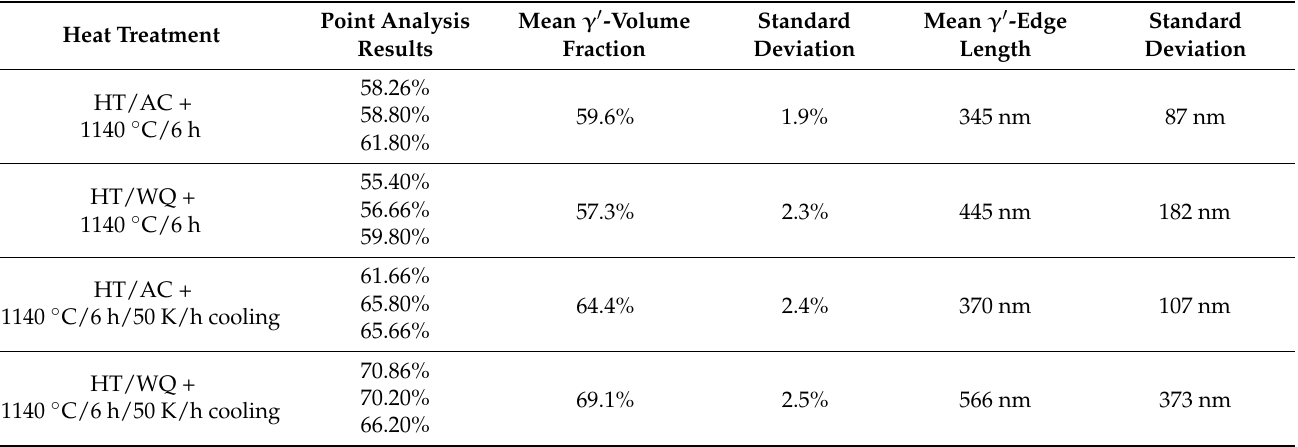
Table 2. γ (cid:48) -edge length and γ (cid:48) -volume fraction of the AC and WQ samples with additional heat treatment at 1140 ◦ C with subsequent AC or